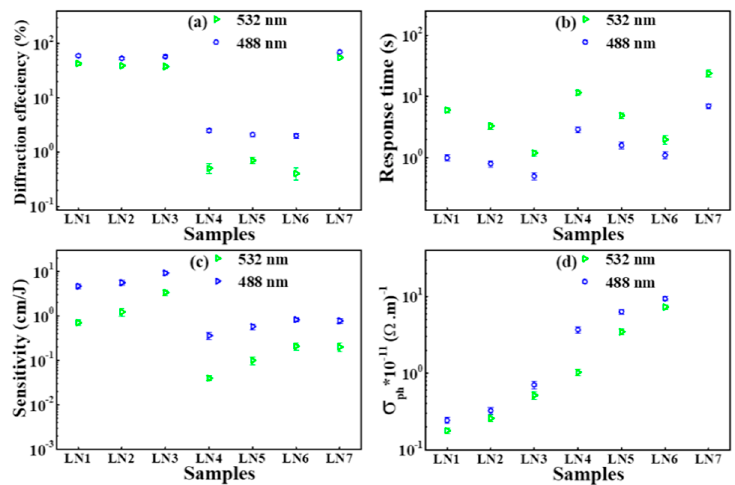
Figure 2. The measured ( a ) diffraction efficiency, ( b ) PR response time, ( c ) sensitivity, and ( d ) photoconductivity ( σ ph ) of LN-doped (LN1–LN7) at 532 nm and 488 nm, respectively.